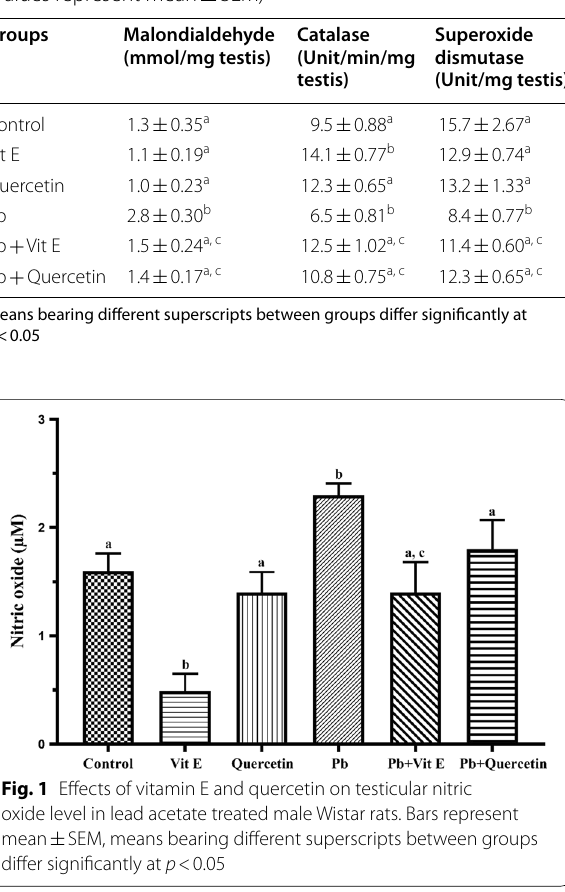
Table 1 Effect of Vitamin E and quercetin on testicular oxidant and antioxidant enzymes in lead acetate treated male Wistar rats (Values represent mean SEM) ±